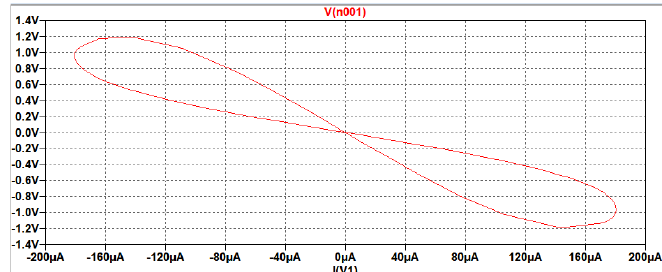
Figure 2. Resistance state simulation diagram of memristor.